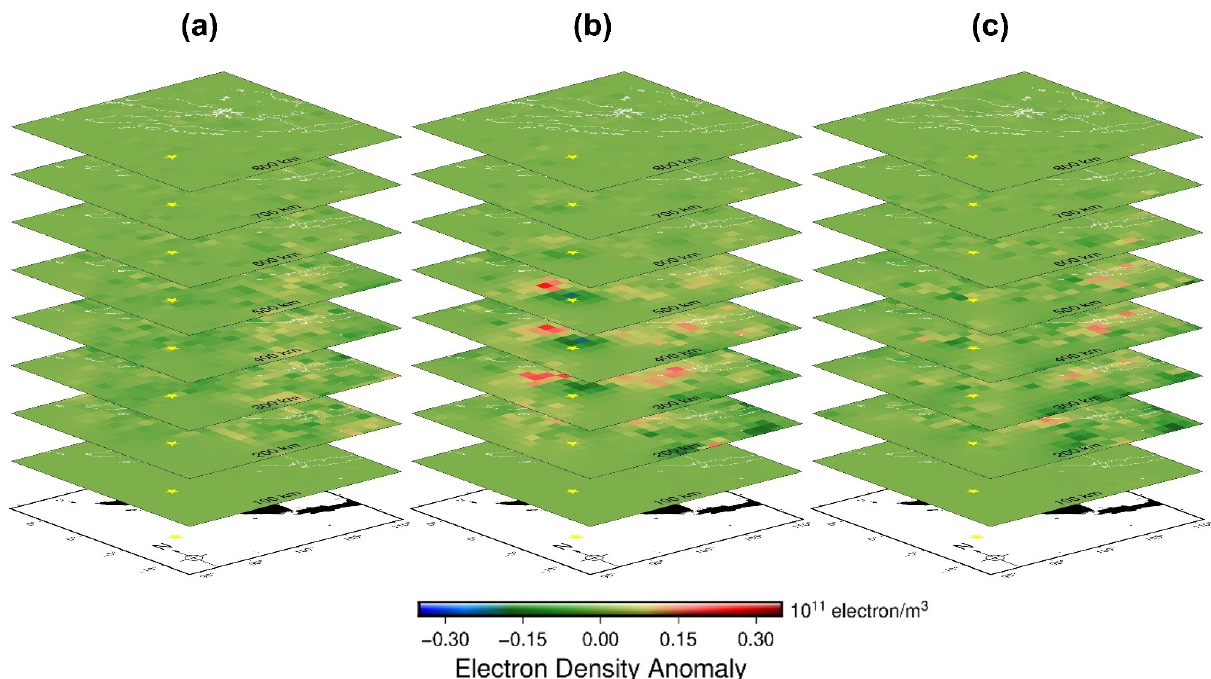
Figure 5. Electron density anomalies at heights from 100 km to 600 km after the 2016 west Sumatera earthquake derived by the 3-D tomography, that is, ( a ) at the time of earthquake, ( b ) 16 min after earthquake, and ( c ) 21 min after earthquake. The white curves show coastlines and nation boundaries, and the yellow star indicates the epicenter.